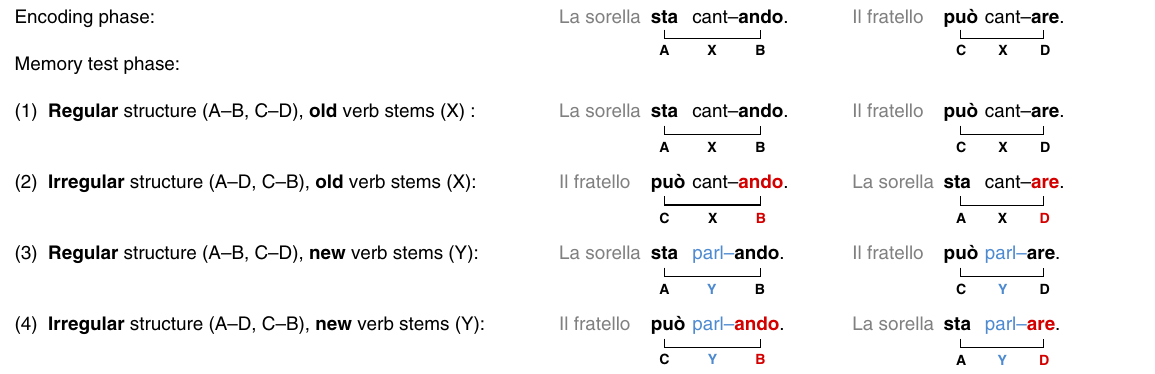
old verb stems of the encoding phase (AXD, CXB), (3) sentences with regular structure, but new verb stems (AYB, CYD), and (4) sentences with irregular struc- ture and new verb stems (AYD, CYB). The probability of occurrence of elements ( A , B , C ,and D )wasequalinallconditions.Inaddition,alltransitionalprobabilities of adjacent elements were kept